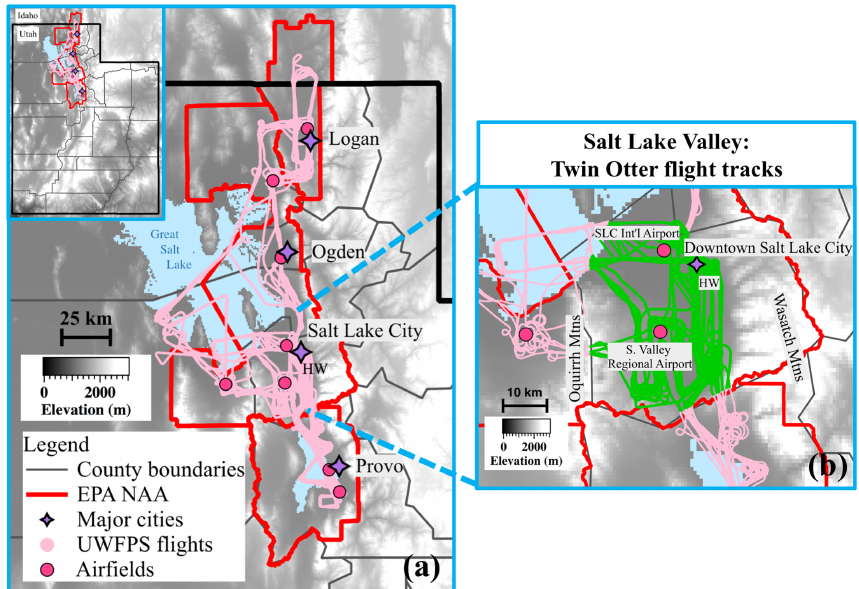
Figure 1. (a) Elevation map of Utah’s Wasatch region (Utah State in insert), with the Great Salt Lake (north) and Utah Lake (south) shown in blue and county borders in gray. The US-EPA-designated nonattainment areas (NAA) for PM 2 . 5 are shown by red boundaries. From north to south these NAAs include the Logan NAA: moderate status, Salt Lake City NAA: serious status, and Provo NAA: serious status. UWFPS Twin Otter flight tracks are shown in pink. Purple markers indicate the locations of major cities, including Logan in the Cache Valley, Ogden and Salt Lake City in the SLV, and Provo in the Utah Valley. The locations of missed approaches conducted with the aircraft are shown by dark pink circles. The Hawthorne (HW) measurement site in the SLV is labeled. (b) Expanded view of the SLV, with analyzed flight tracks highlighted in